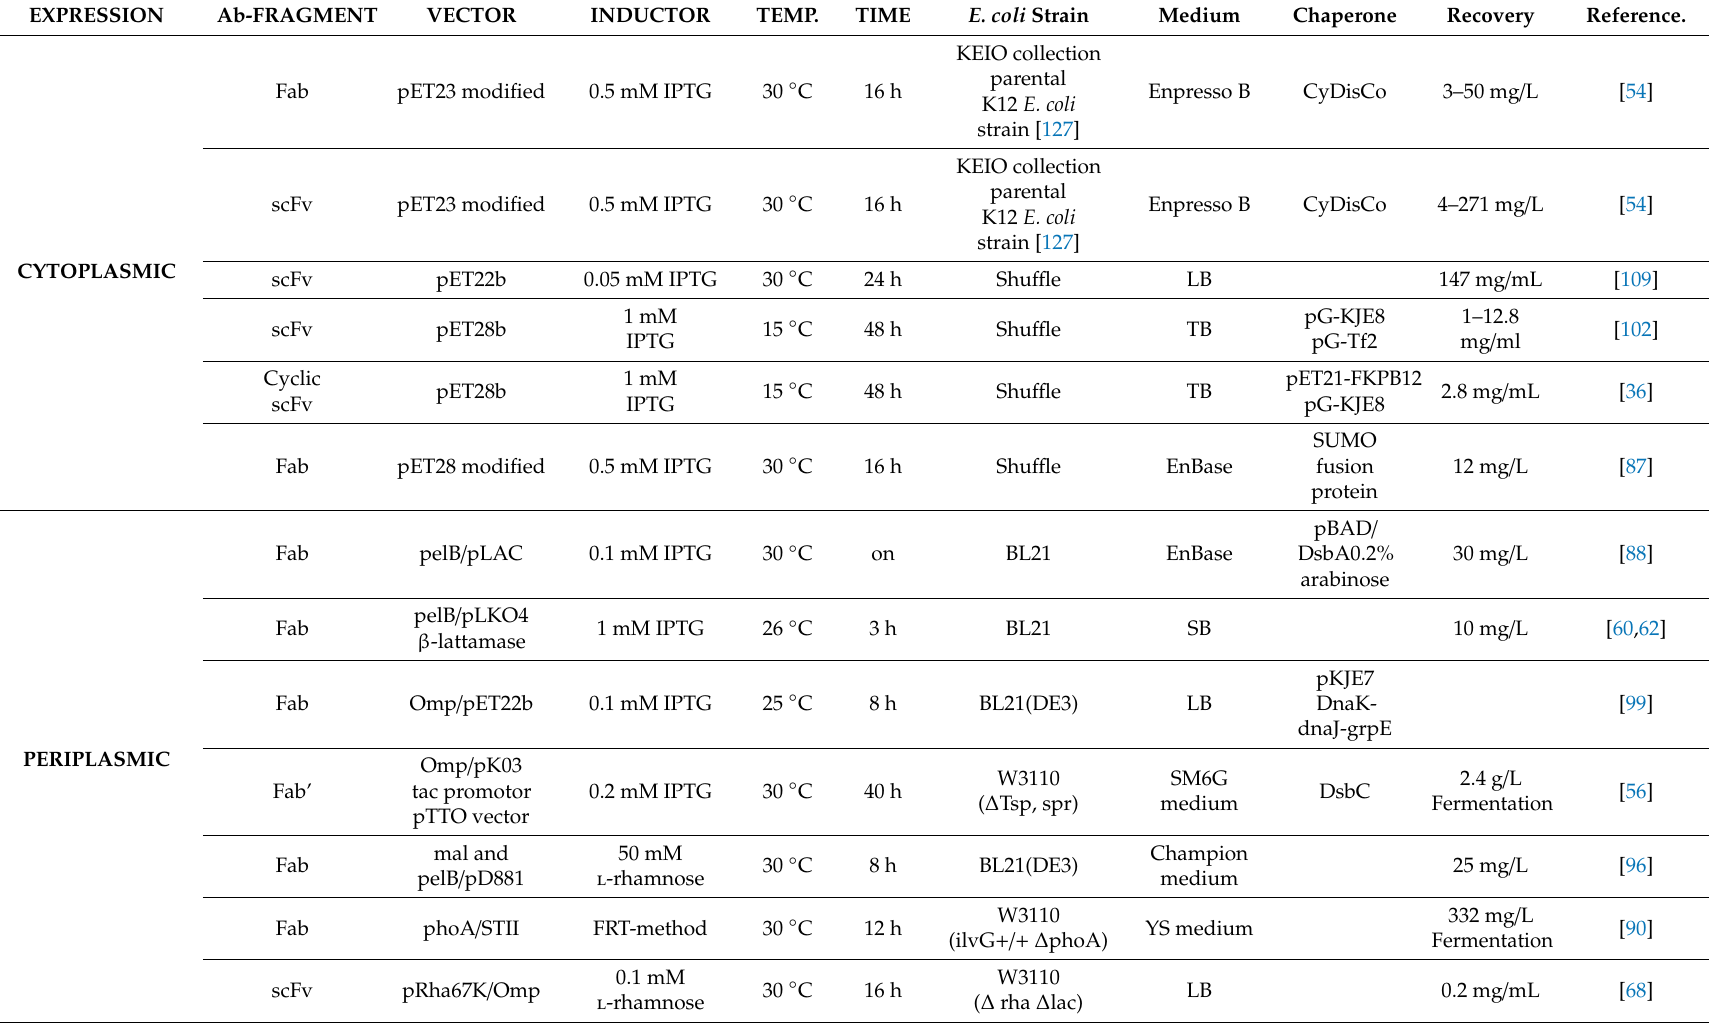
Table 2. Summary of most relevant reported experimental settings for the production of Fab and scFv recombinant fragments in di ff erent E. coli compartments.